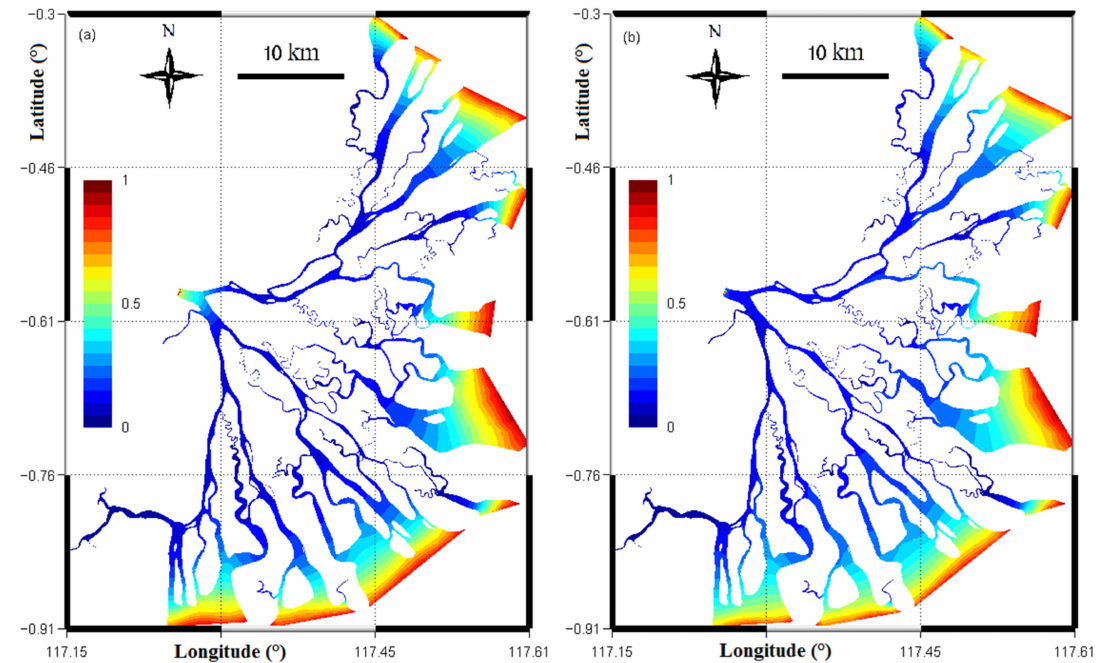
Figure 13. Distribution of the return coe ffi cient for the: ( a ) low; ( b ) high flow